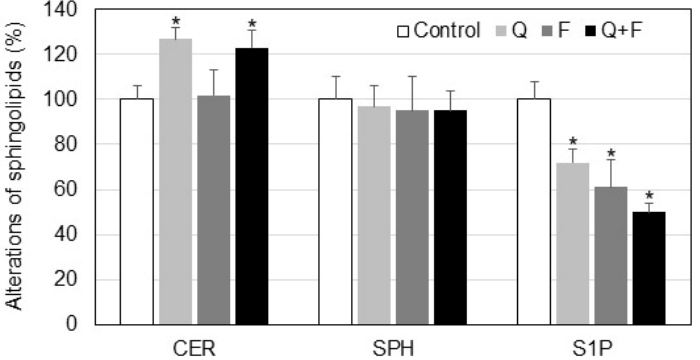
Figure 4. Changes in the level of ceramide (CER), sphingosine (SPH) and sphingosine-1-phosphate (S1P) in control and treated with quercetin (Q) and fingolimod (F) HepG2 cells. Values are expressed as % of controls. Values are means ± SD. Statistical significance is presented as comparison of treated cells with controls. * p < 0.01.